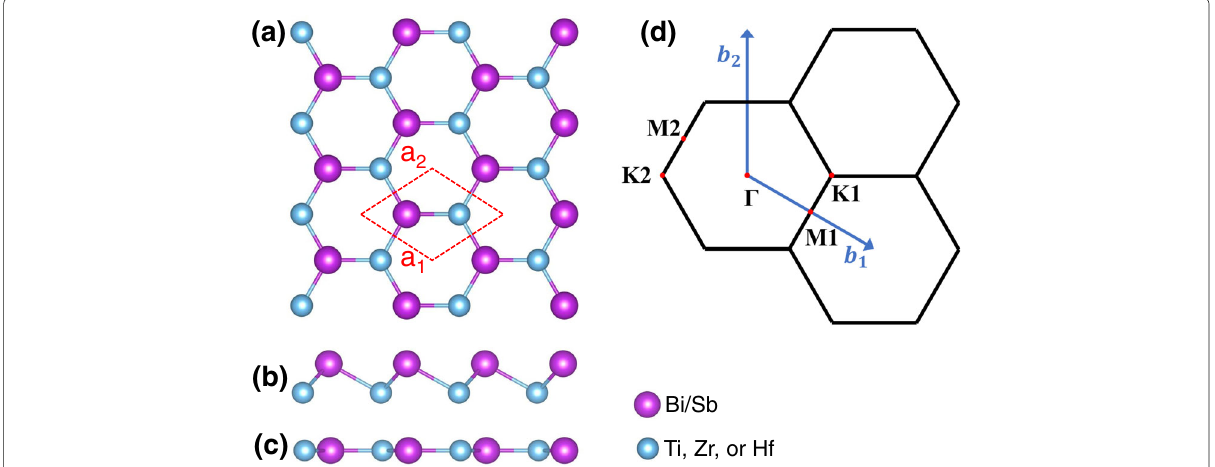
Fig. 1 a Crystal structure of M-Sb/Bi honeycomb. b , c Side views of buckled and planar structures, respectively. d The first Brillouin zone (BZ) with high-symmetry